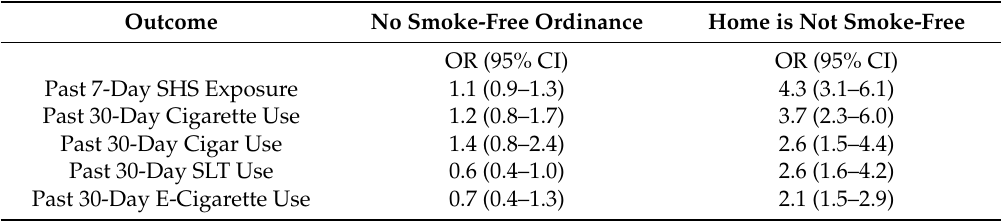
Table 4. Logistic regression of SHS exposure and tobacco use on smoke-free policies 1